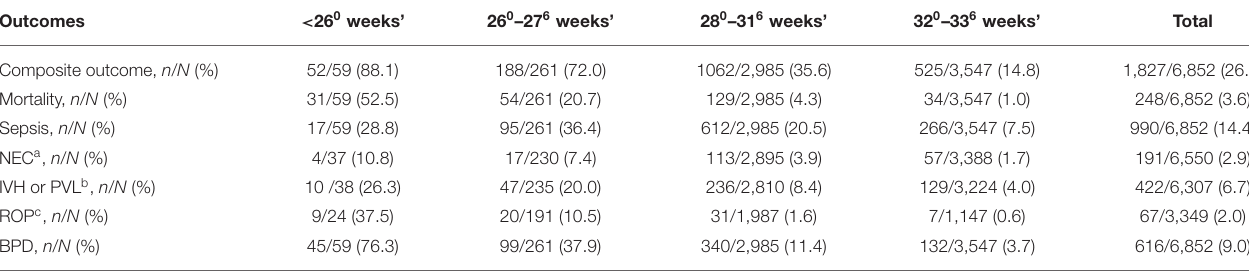
TABLE 2 | Outcome rates of infants born at < 34 weeks’ gestation and receiving complete care by gestational age.